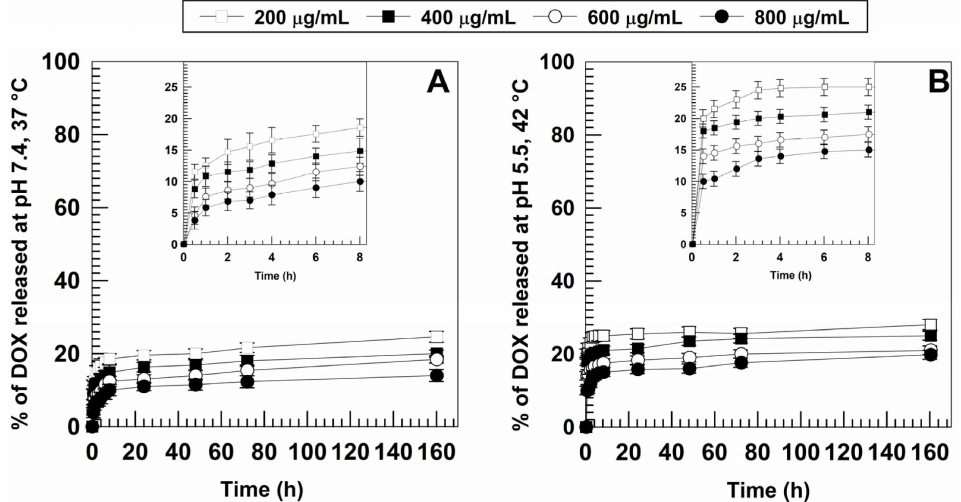
Figure 4. Release profiles of DOX (0.2–0.8 mg/mL) from gliadin nanoparticles (1 mg/mL of protein, 0.1% w/v of polyoxyethylene (2) oleyl ether) evaluated in ( A ) physiological and ( B ) in simulated tumor conditions and expressed as a function of the amount of DOX entrapped and incubation time. Error bars, if not shown, are within the symbols. Values represent the mean of five different experiments ± standard